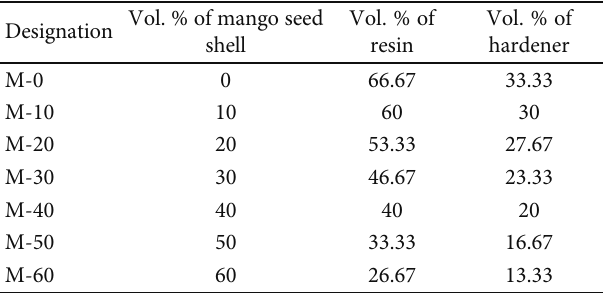
Table 1: Volume ratio of di ff erent constituents of the composite specimens